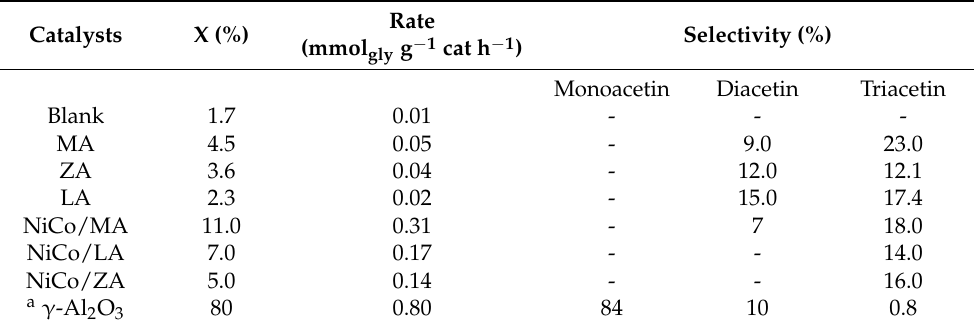
Table 4. Glycerol conversions, reaction rates and product selectivities for the catalysts evaluated in 1h of EG reaction. Reaction conditions: glycerol to acetic acid (molar ratio) = 1:3, reaction temperature = 80 ◦ C, catalyst mass = 0.50